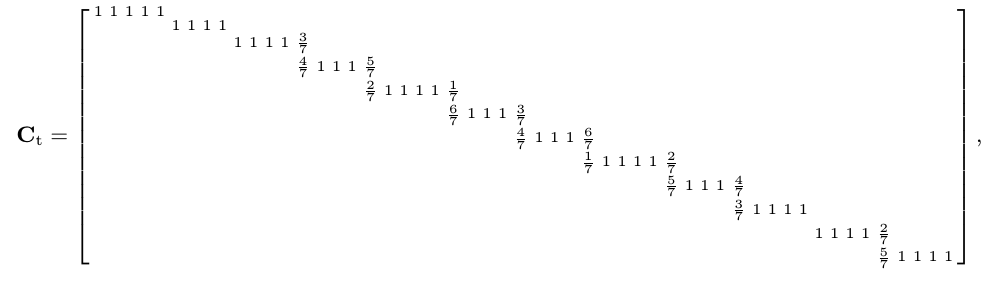
Fig 3a shows a fine grid composed of 4871 regular cells of size 1000 m × 1000 m. Blue dots represent the spatial coordinates of the centroids of these cells, and Fig 3b shows the spatial distribution of the population on this fine grid, which is heterogeneous across municipalities. To set up the ST-PCLM formulation, we have used: centroids of the cells described in Fig 3a as fine-scale spatial coordinates, i.e., as x and x , x = (1, . . . , 53) 0 (since 53 weeks were observed 1 2 3 in 2009), second order penalties, 12 equally-spaced knots for the marginal cubic B-spline bases B and B , and 8 equally-spaced knots for the marginal cubic B-spline basis B . We have 1 2 3 assumed here that the population at the fine grid is constant throughout the time period; thus, e in model (6) is considered as a vector obtained by repeating the fine-scale population fifty f three times. The elements of the spatial composition matrix are obtained using Eq (5), whereas the temporal composition matrix for this case has the following form: